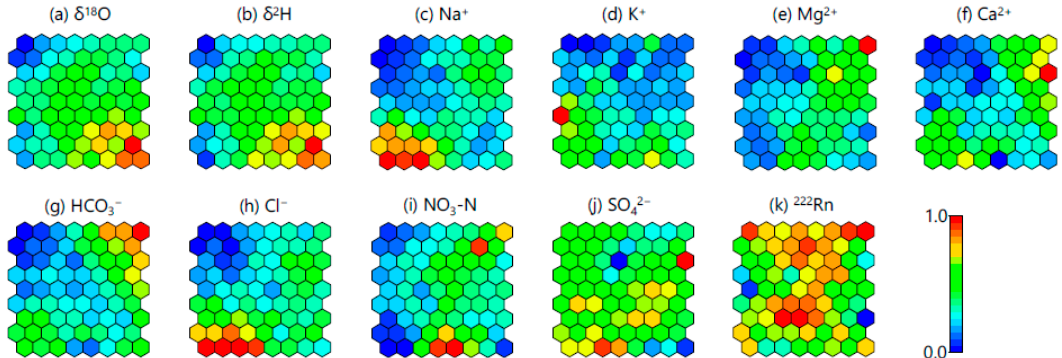
Figure 10. Component planes of the isotopic and hydrochemical parameters: ( a ) δ 18 O, ( b ) δ 2 H, ( c ) Na + , ( d ) K + , ( e ) Mg 2+ , ( f ) Ca 2+ , ( g ) HCO 3 − , ( h ) Cl − , ( i ) NO 3 -N, ( j ) SO 42 − , and ( k ) 222 Rn. Each plane shows the standardized value of each parameter (transformed to the range from 0 to 1) in each node.